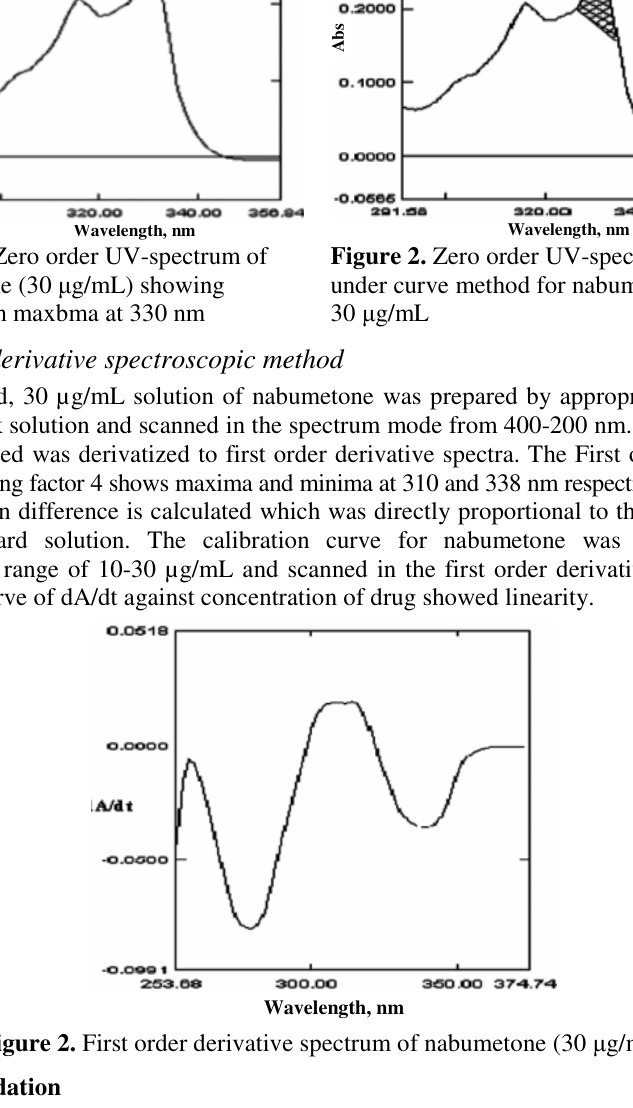
Figure 2. Zero order UV-spectrum of area under curve method for nabumetone, 30 µ g/mL